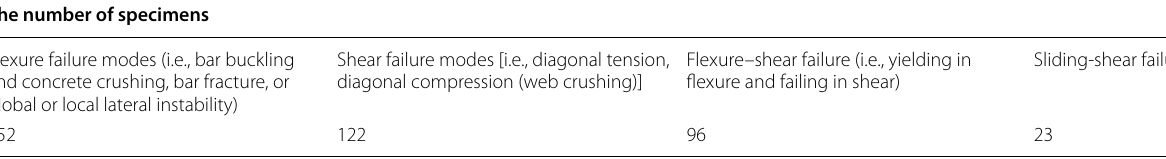
Table 1 Distribution of failure